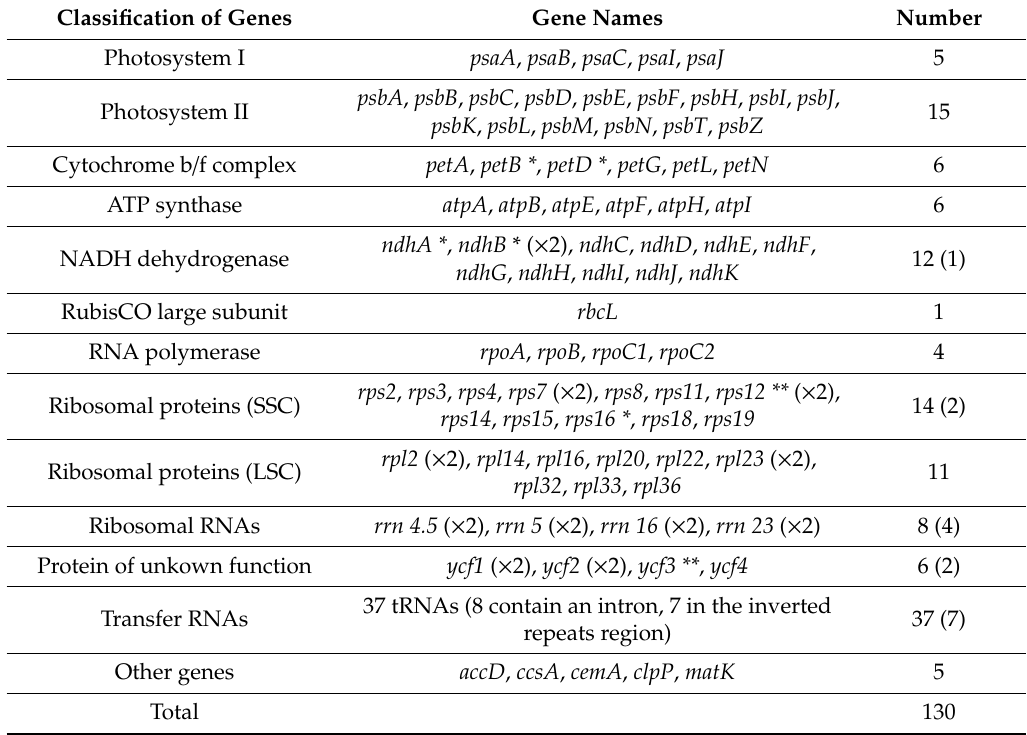
* indicates gene containing one intron; while ** indicates gene with two introns.